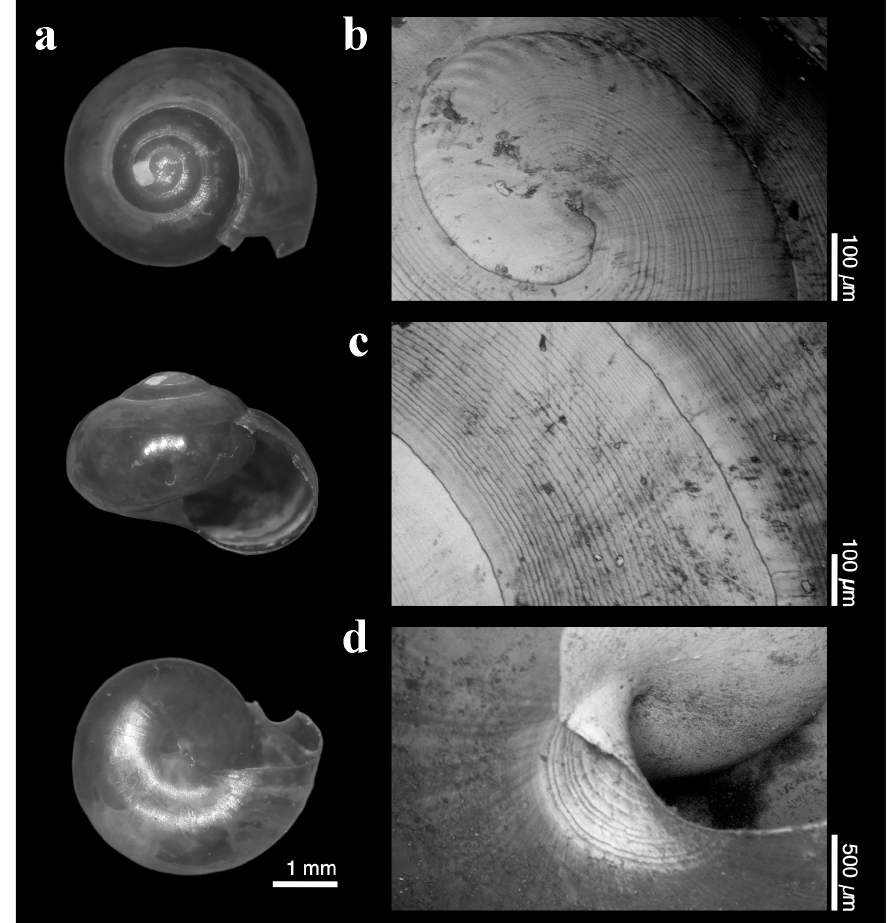
Figure 3 - External-shell morphology of Ovachlamys fulgens from Eldorado city. a, dorsal, apertural, and umbilical views (top to bottom); b-d, scanning electron micrographs: b, protoconch view; c, detail of shell sculpture; d, view of spiral cords at